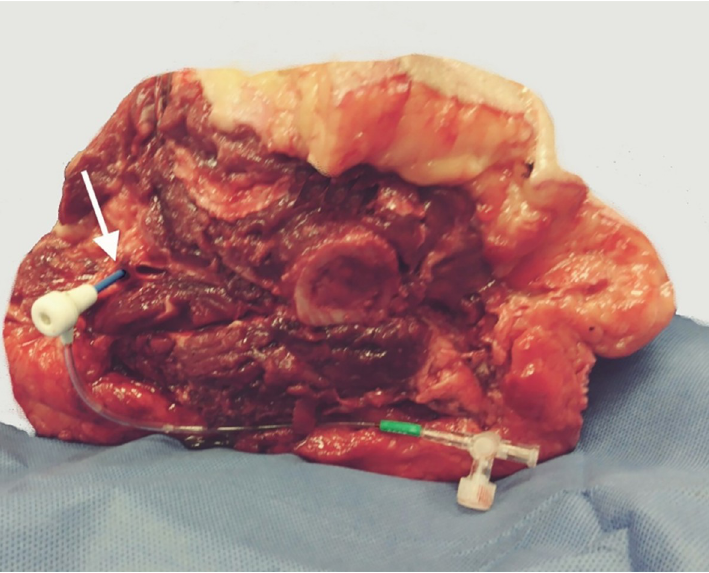
Fig 2. Cannulation of the femoral artery of a lower extremity. A 7Fr sheath is used to create antegrade access of the lower extremity through the vacant femoral artery (white arrow) in the axial dissection plane.